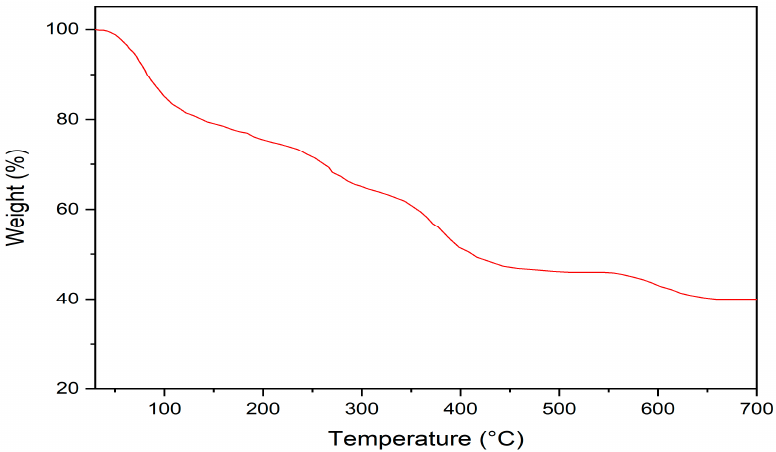
Figure 3. TGA profile of the prepared Bio-MOF (MIP-202).